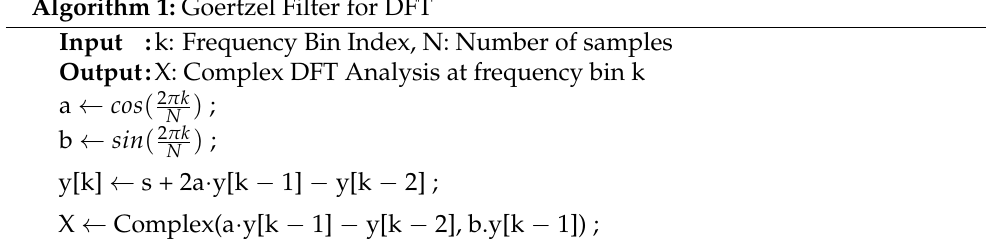
Algorithm 1: Goertzel Filter for